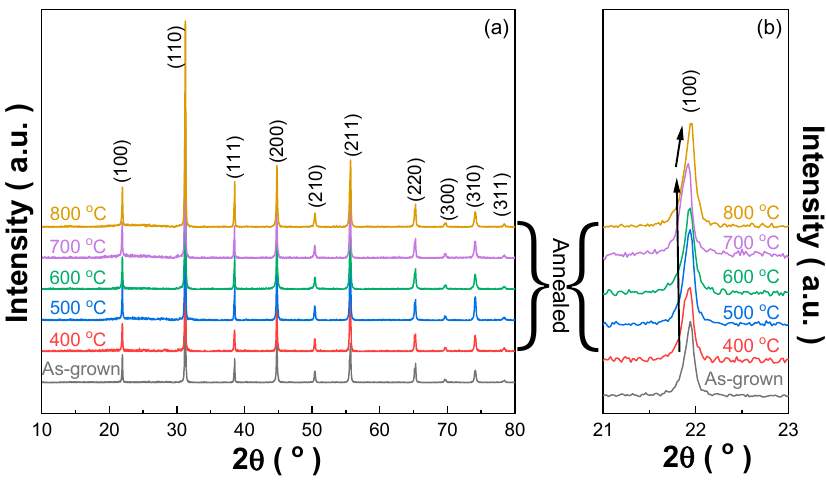
Figure 1. XRD patterns of the Mn:PIMNT crystal powder. ( a ) 10 ◦ –80 ◦ ; ( b ) 21 ◦ –23 ◦ (expanded XRD patterns of the (100) di ff raction peak). Abbreviations: Mn:PIMNT, Mn:0.15Pb(In 1 / 2 Nb 1 / 2 )O 3 -0.55Pb(Mg 1 / 3 Nb 2 / 3 )O 3 -0.30PbTiO 3